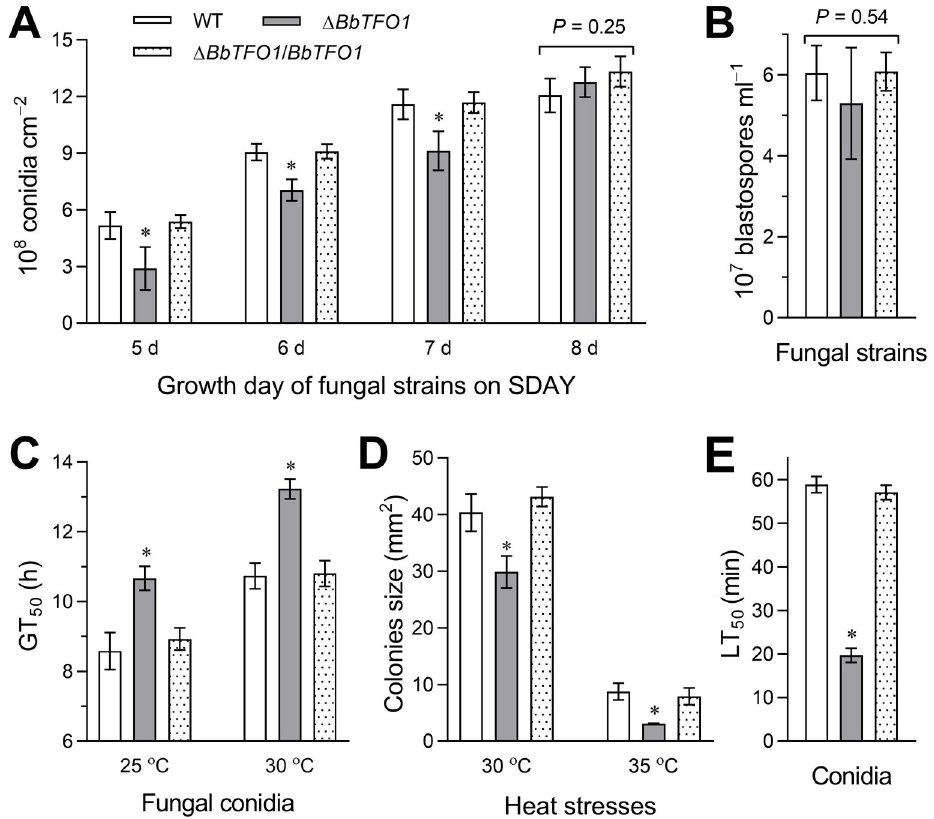
Fig 3. BbTFO1 disruption affects fungal conidiation and conidial quality (A) Conidiation was counted daily from 5 days to 8 days on SDAY plates, which was started with smearing an appropriate amount of conidial suspension (100 μ l, 10 7 conidia ml − 1 ). (B) The yield of blastospores was counted in NLB after 3 days of incubation at 25˚C. (C) The GT 50 (h) necessary to achieve 50% conidial germination at 25˚C and 35˚C. (D) Colony size in different strains grown at 30˚C and 35˚C for 7 days on CPZ medium. (E) The LT 50 (min) of heat stress resistance in conidia at 45˚C. The bar marked with an asterisk for every three-bar group showed a significant difference (Tukey’s HSD, P < 0.05). Error bars: SD of 3